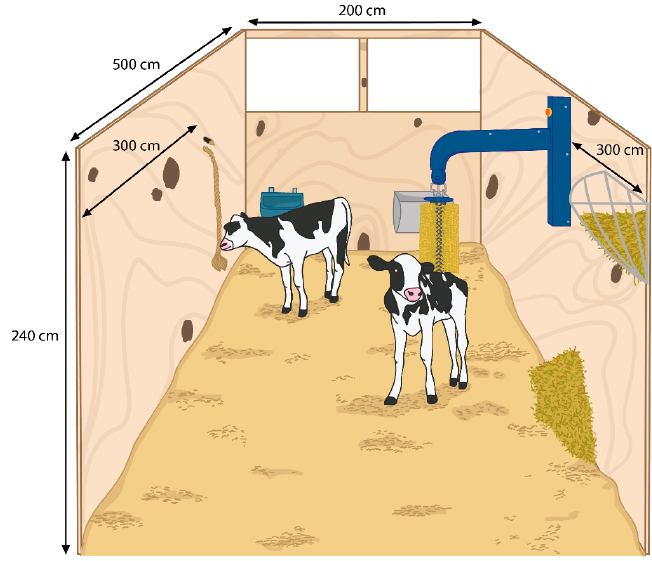
Figure 1. Pen layout for 8 identical pens containing an automated brush and a 1 m length of manila rope. Water, concentrate, and hay were provided ad libitum. Pens were bedded with wood shavings and housed 2 calves. One calf per pen was selected as the focal animal for observation.